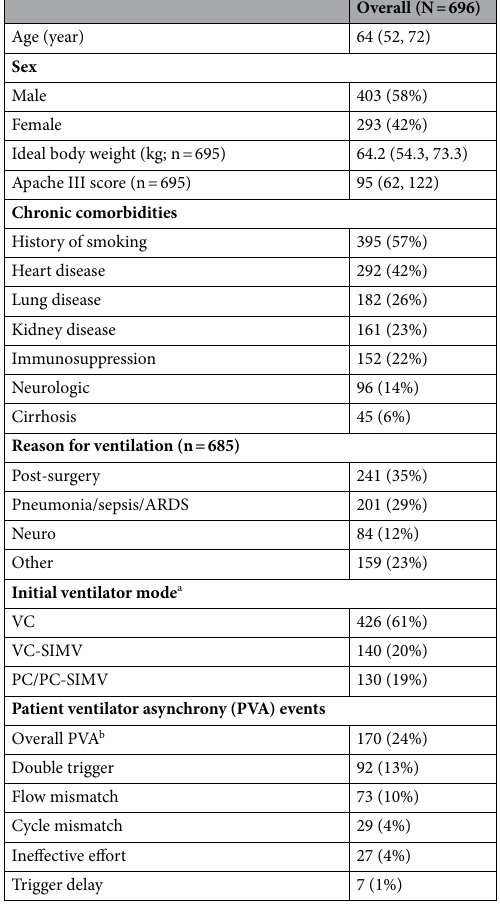
Table 1. Patient demographics, comorbidities, initial ventilator mode, and number and percentage of all patients experiencing events at any time during mechanical ventilation. Variables are summarized as median (25th percentile, 75th percentile) or number and percentage as appropriate. When all data are not available, numbers with complete data are presented. Data represent 696 episodes of mechanical ventilation in 676 unique patients. In total, 13 patients had greater than 1 episode, with 1 patient having 6 episodes. a Initial ventilator mode reflects the first mode recorded following ventilation start. It may not be the mode at the start time of ventilation. b Overall PVA included flow starvation, double triggering, ineffective effort, delayed triggering and cycle